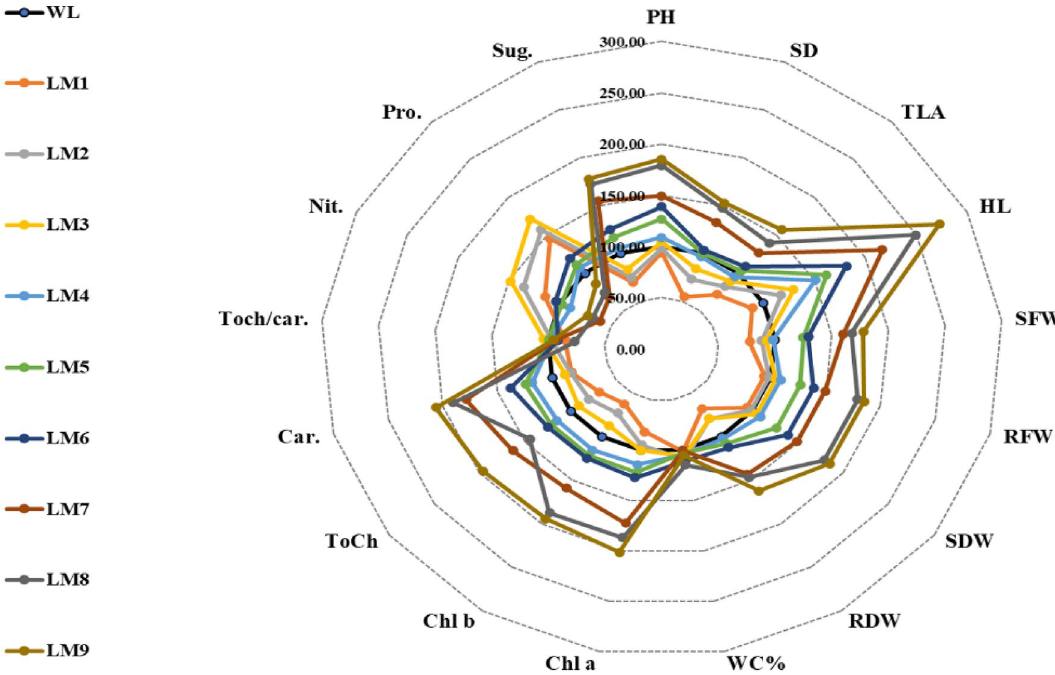
Figure 4. Radar plot of all studied traits under various light modes. Where PH Plant height, SD Stem diameter, TLA Total leave area, HL Hypocotyl length, SFW Shoot fresh weight, RFW Root fresh weight, SDW Shoot dry weight, RDW Root dry weight, WC % Water content, Chl a Chlorophyll a, Chl b Chlorophyll b, ToCh Total Chlorophyll contents, Car. Carotenoid, ToCh/Car. Total Chlorophyll contents/Carotenoid, Nit. Nitrate content, Pro. Protein content, and Sug. Sugar content.